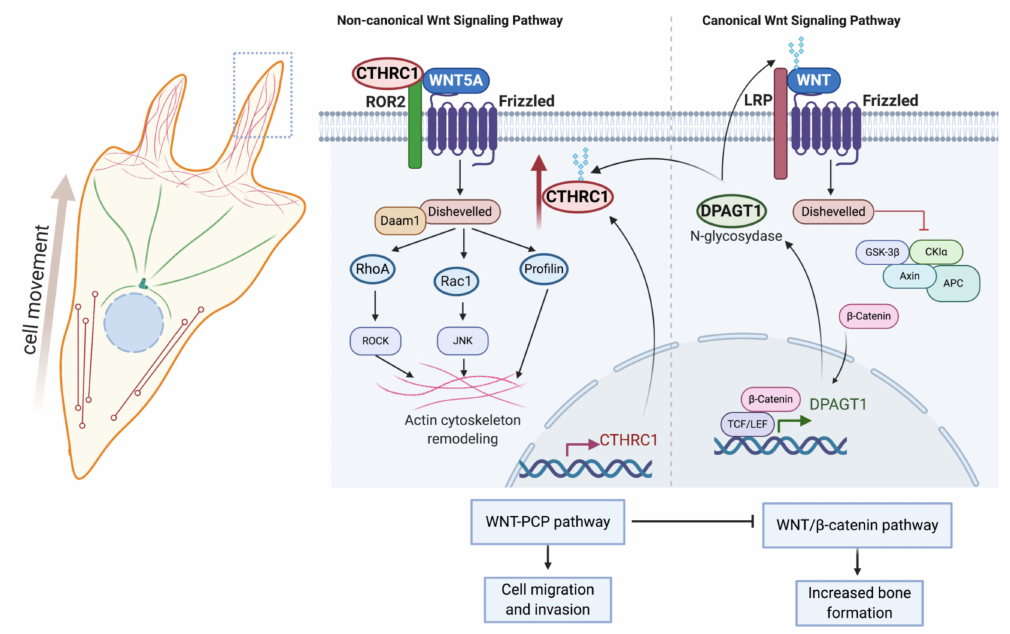
Figure 3. Role and regulation of CTHRC1 in canonical and noncanonical Wnt signaling. Expression of the N-glycosidase DPAGT1 is induced in response to activation of canonical Wnt/ β -catenin signaling. DPAGT1 mediates the N-glycosylation of Wnt ligands and of CTHRC1, thereby enhancing protein stability and secretion of CTHRC1. CTHRC1, in turn, attenuates signaling by the canonical Wnt/ β -catenin pathway and induces cytoskeletal reorganization and cell movement via activation of noncanonical Wnt/PCP signaling. Secreted CTHRC1 activates the Wnt/PCP pathway by acting as a co-receptor and promoting the formation of the WNT5A/FZD/ROR2 complex. Created with